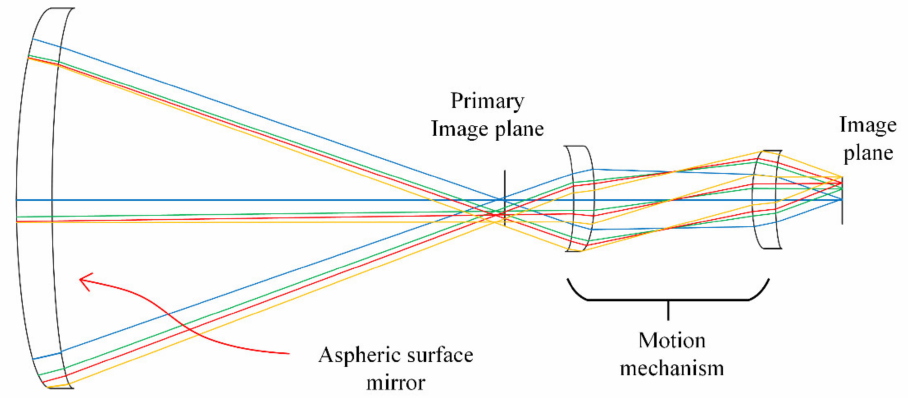
Figure 11. The optical